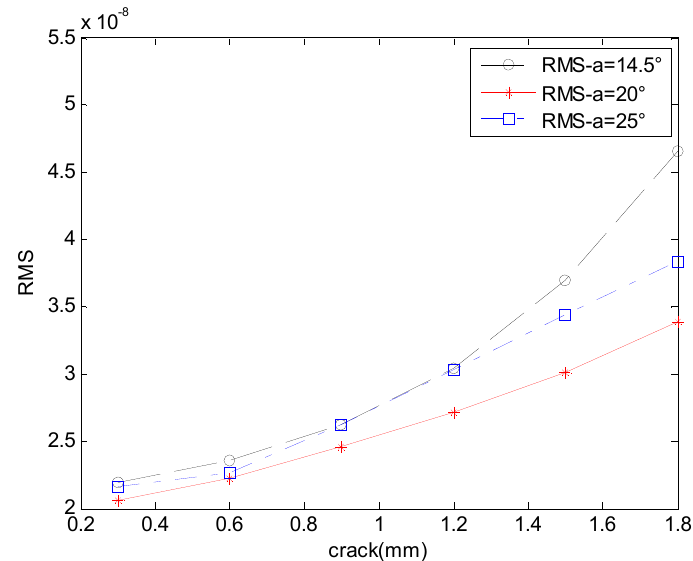
Figure 13. The Root Mean Square (RMS)of the vibration response in different pressure angles.